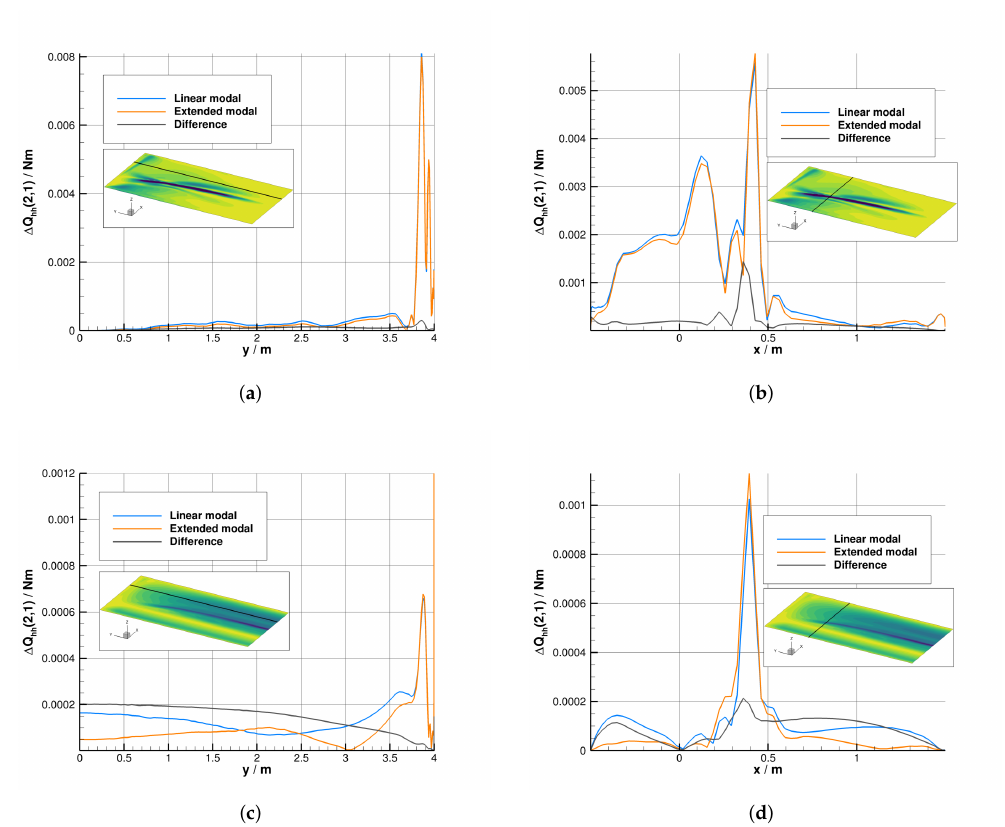
Figure 19. Nonlinear components of Q hh ( 2,1 ) along spanwise and chordwise slices (viscous flow, Mach 0.8). ( a ) Longitudinal component, spanwise distribution at x / c = 0.725; ( b ) longitudinal component, chordwise distribution at y / s = 0.7; ( c ) lateral component, spanwise distribution at x / c = 0.725; ( d ) lateral component, chordwise distribution at y / s =